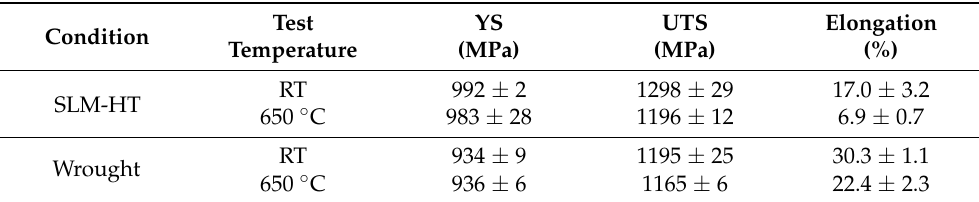
Table 3. Summary of tensile results for SLM-HT and wrought IN718 specimens tested at RT and 650 ◦